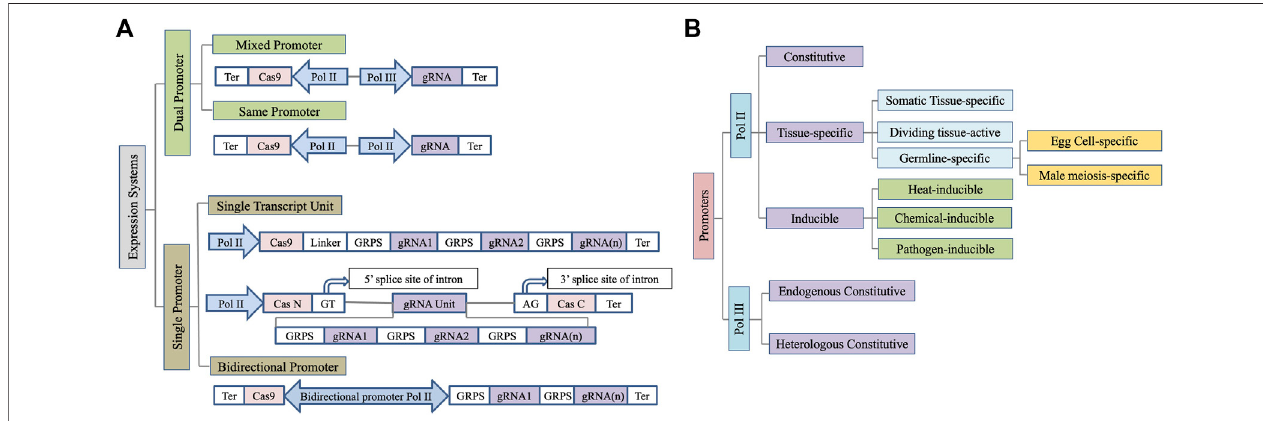
FIGURE 1 | Schematic depiction of wide range of (A) expression systems and (B) promoters used for Cas9/gRNA expression in plants. Ter, Terminator; GRPS, Guide RNA processing system.